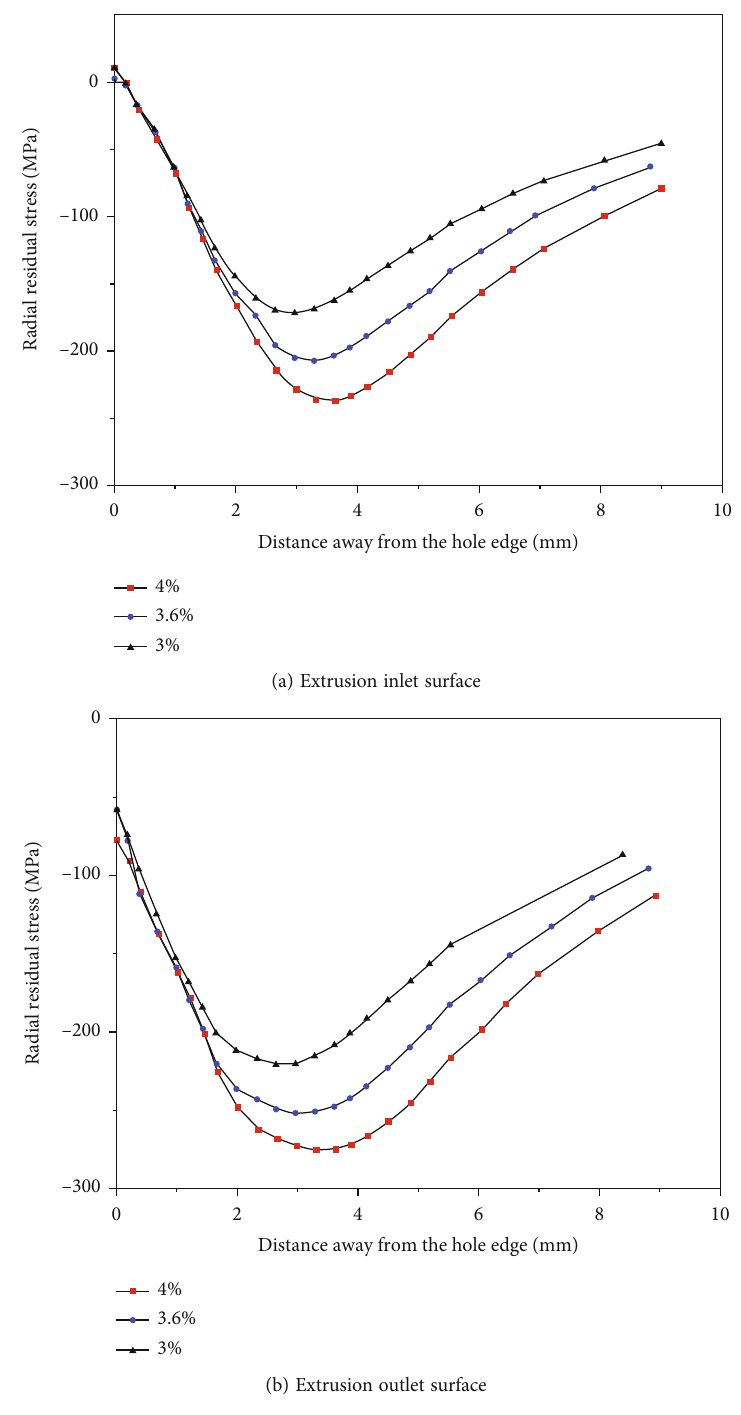
Figure 14: Radial residual stress distribution law under di ff erent squeezing